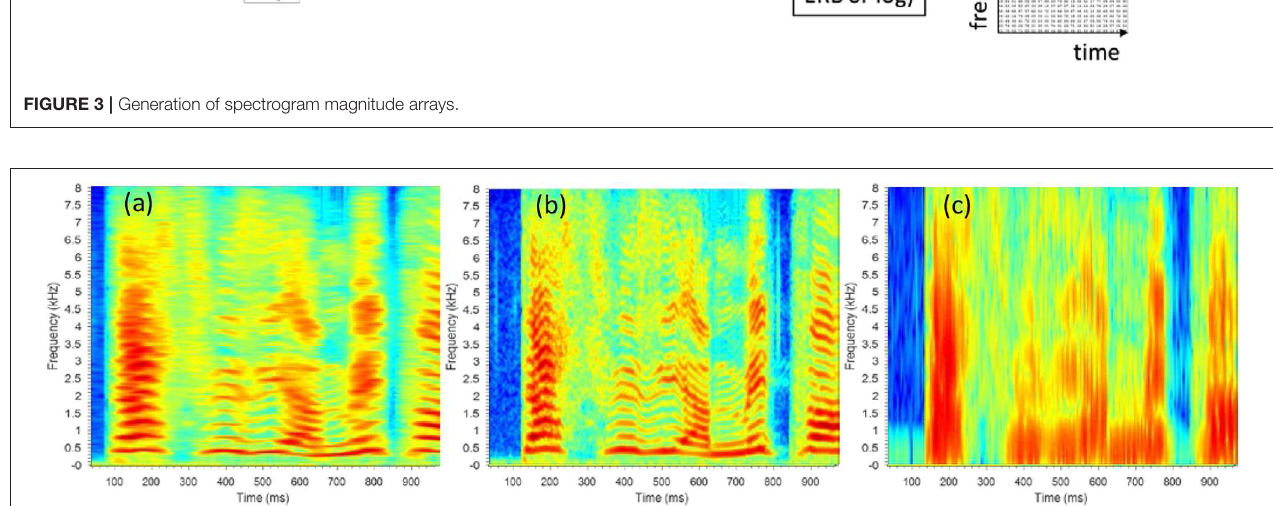
FIGURE 4 | Examples showing how the time-frequency resolution trade-off affects spectrogram features visualization when changing bandwidth (BW) and time length (w) of the Hamming window: (a) BW = 25Hz, w = 72ms, 1 t = 6ms; (b) BW = 118Hz, w = 16ms, 1 t = 4ms; (c) BW = 1,000Hz, w = 1.8ms, 1 t =